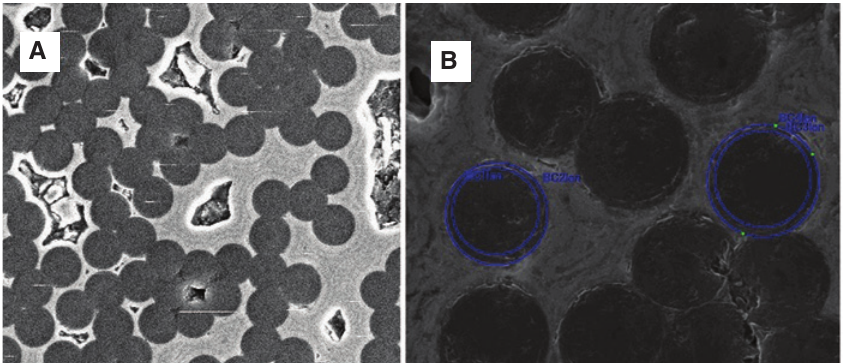
Figure 7: Cross section of the fiber bundle: (A) phase diagram cross-section of the fiber bundle; (B) cross section of the fiber with coating.